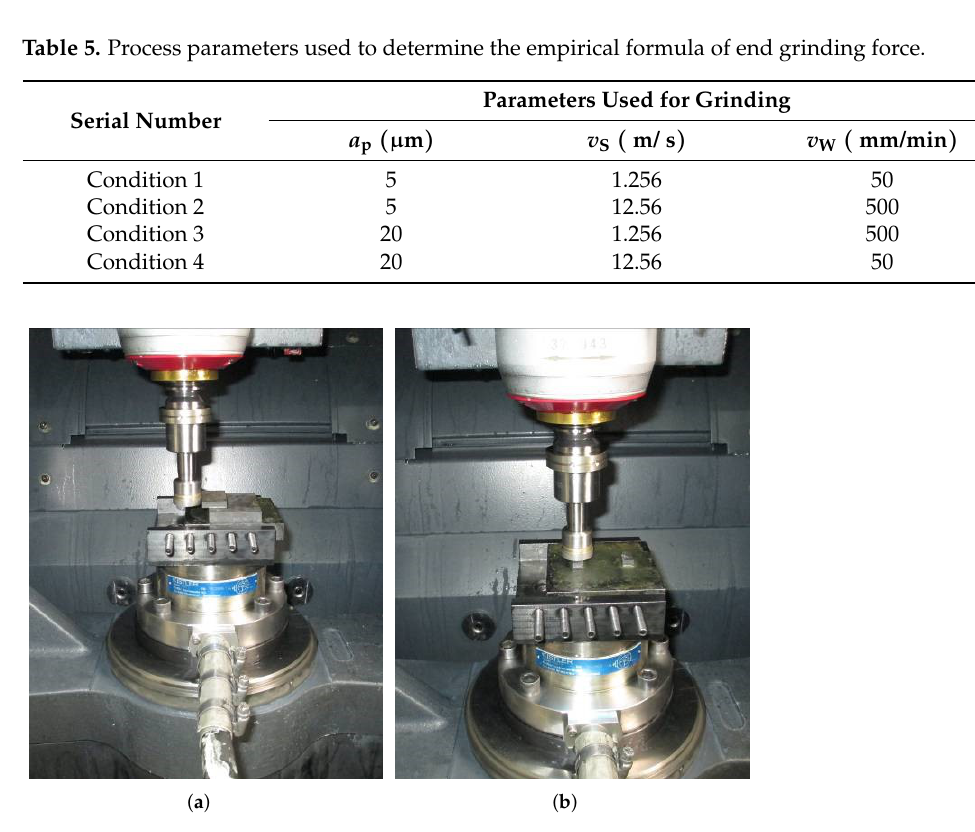
Figure 4. ( a ) Side grinding force measurement system. ( b ) End grinding force measurement